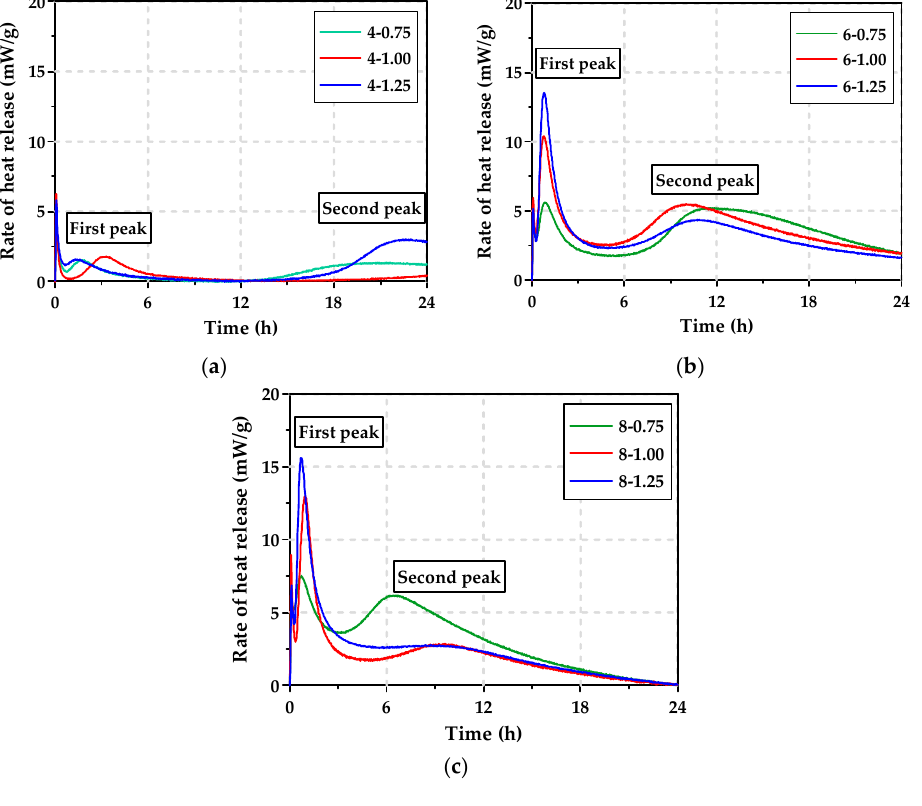
Figure 4 . Rate of heat release curves of AAS pastes for 24 h: ( a ) Na 2 O content = 4%, ( b ) Na 2 O content = 6%, ( c ) Na 2 O content = 8%.